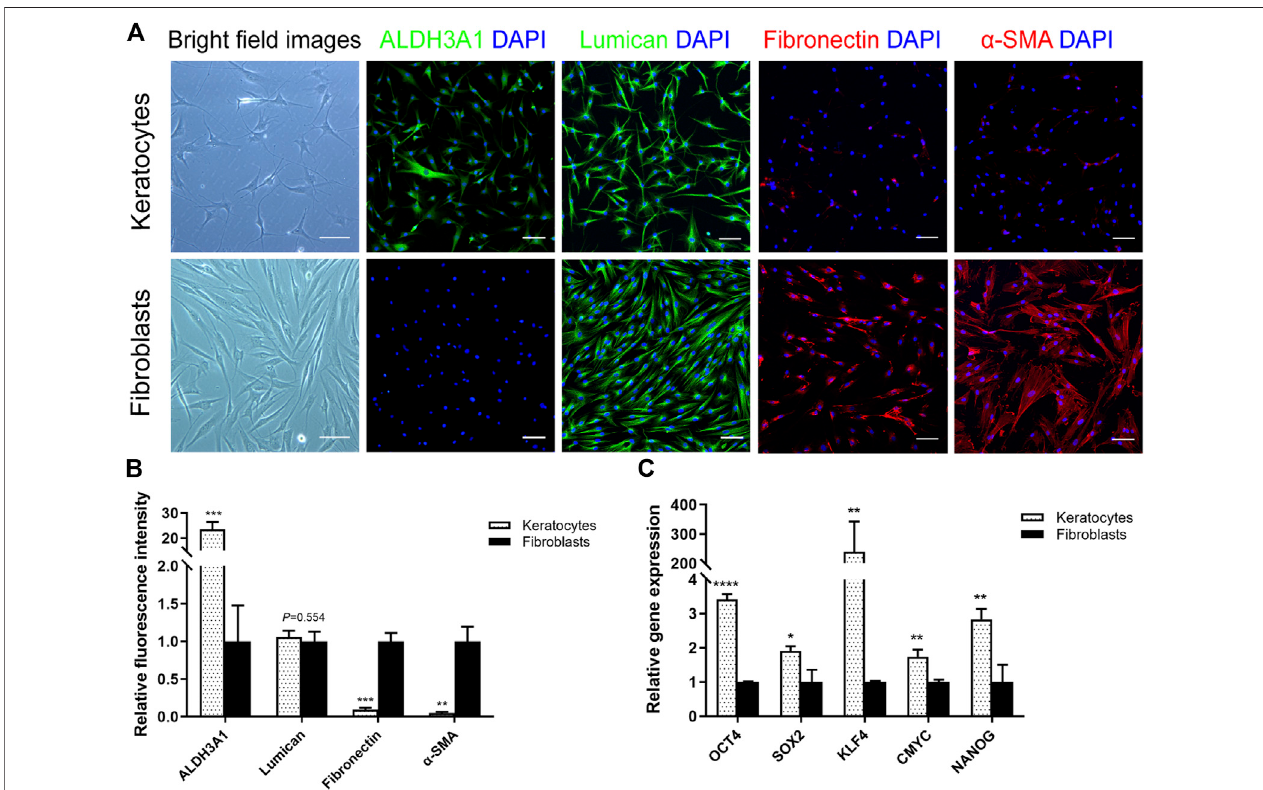
FIGURE 1 | Differences between keratocytes and fi broblasts. (A) Light microscopy revealed that the hCSCs at P2 cultured in soluble porcine corneal stromal extract (pCSE) with low-serum RIFA medium (RIFA + pCSE) or normal medium (NM) had different morphologies. Immuno fl uorescence images of ALDH3A1, lumican, fi bronectin, and α -SMA are shown. (B) Marker expression was represented as average ± S.D. from three independent experiments. (C) The qPCR results showed that the endogenous levels of OCT4 , SOX2 , KLF4 , CMYC and NANOG in keratocytes were higher than those in fi broblasts. (* p < 0.05; ** p < 0.01; *** p < 0.001; **** p < 0.0001). Scale bars: 100 μ